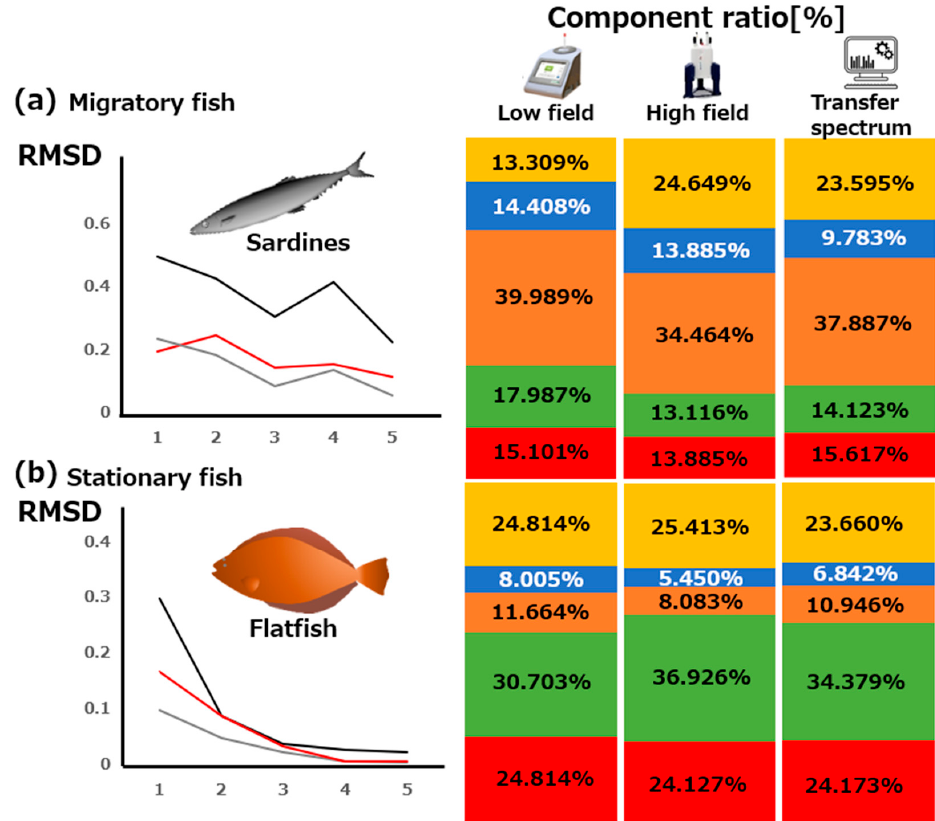
Figure 5. Contents of compounds obtained from low-field, high-field, and transferred NMR spectra in the two fish samples: ( a ) migratory (sardine) and ( b ) stationary (flatfish) fish samples. Component ratios are obtained (from left to right) by low-field NMR, high-field NMR, and transfer NMR simulated spectra. Red, green, orange, blue, and yellow represent the spectrum and component ratio of choline, TMAO, lactate, histidine, and creatine, respectively.